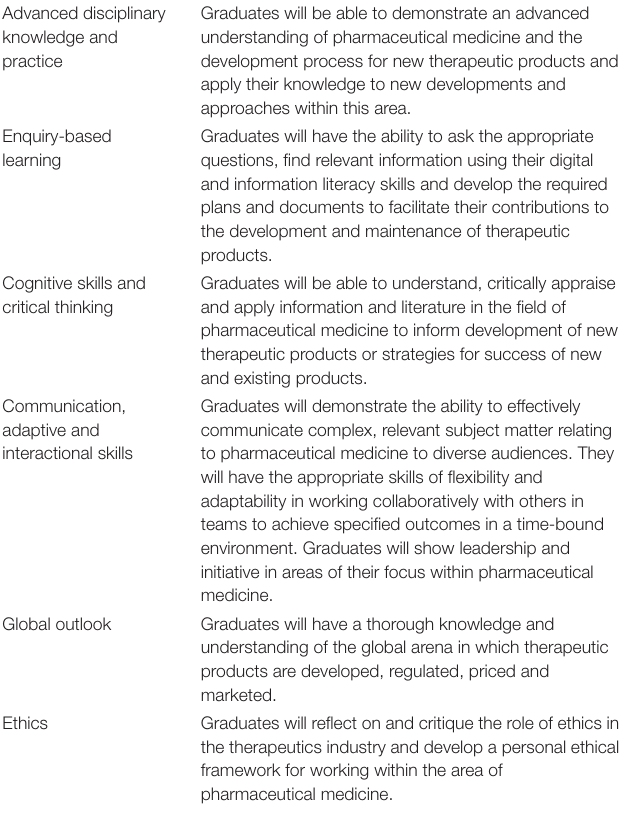
TABLE 1 | Program-level learning